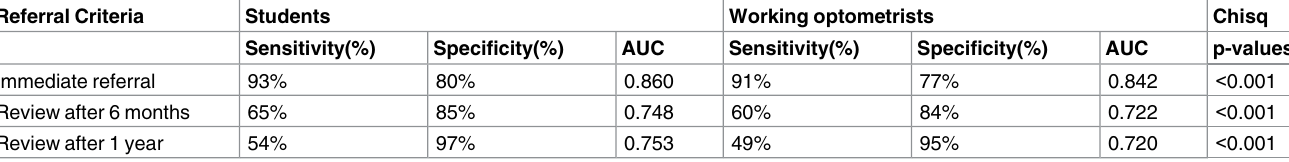
Table 3. Performance of Working Optometrists versus Optometry